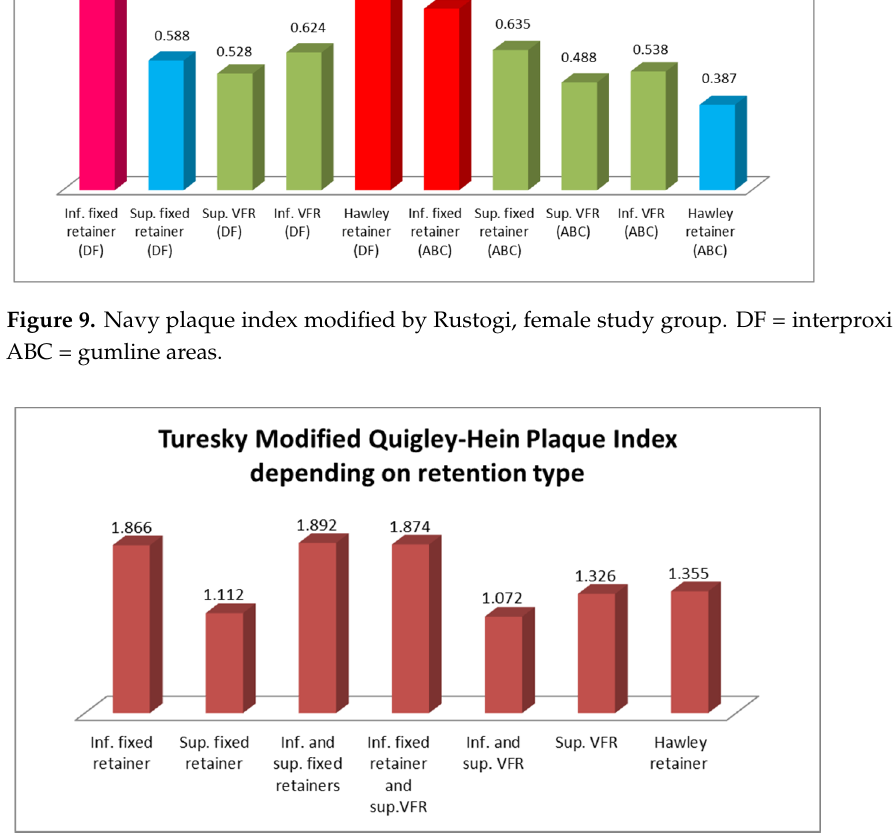
Figure 11. Gingival recession, female group.